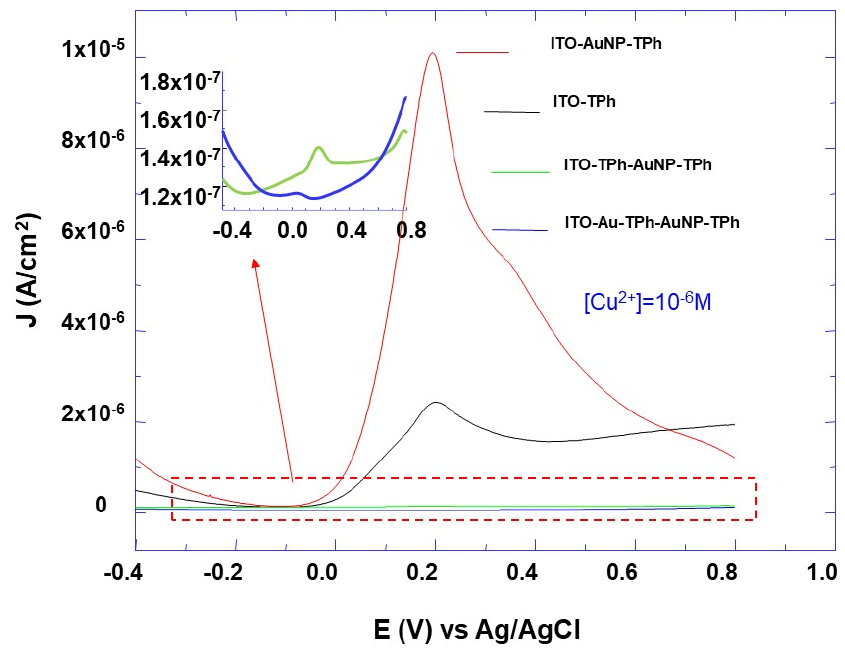
Figure 7. Square wave voltammetry (SWV) curves comparison of ITO electrodes with self-assembled AuNPs and 4-thiolphenyl in an electrolyte aqueous solution of KNO 3 (10 − 1 M) and copper salt (CuSO 4 , 1 × 10 − 6 M). The insert shows the high magnification of the indicated voltammograms by dash rectangles.